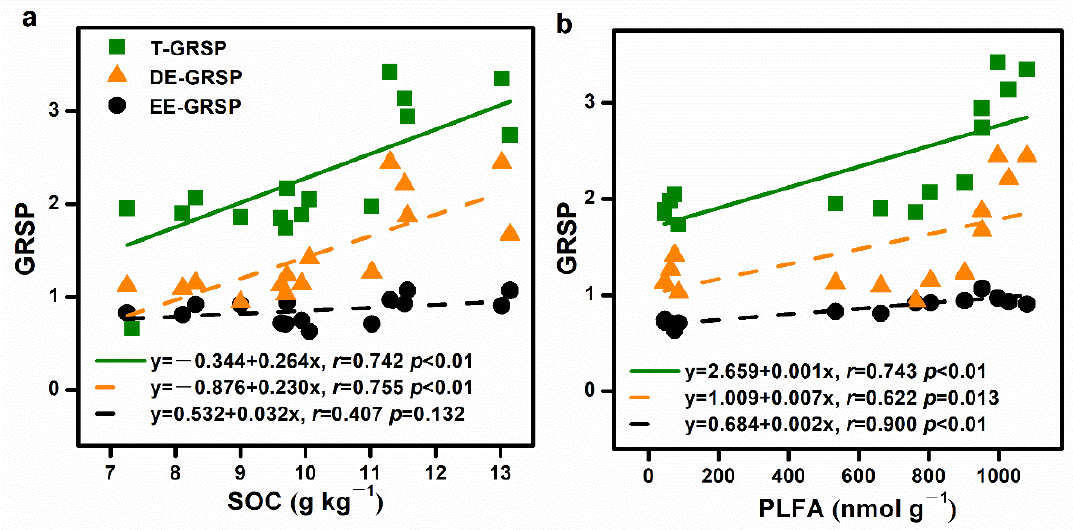
Figure 2. Contribution of EE-GRSP ( a ), DE-GRSP ( b ), T-GRSP ( c ) to soil organic C (SOC) and ratios of EE-GRSP that account for T-GRSP ( d ) during development of C. lanceolata plantations. Bars topped by different letters indicate significant difference ( p < 0.05).